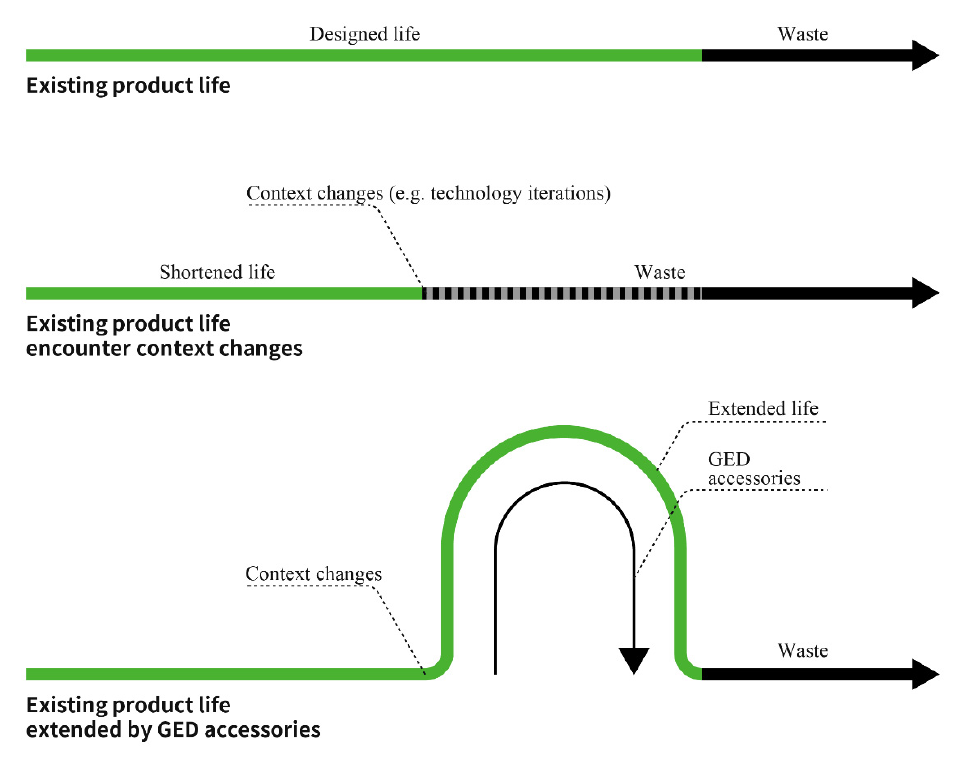
Figure 4. GED strategy for extending the existing product life.